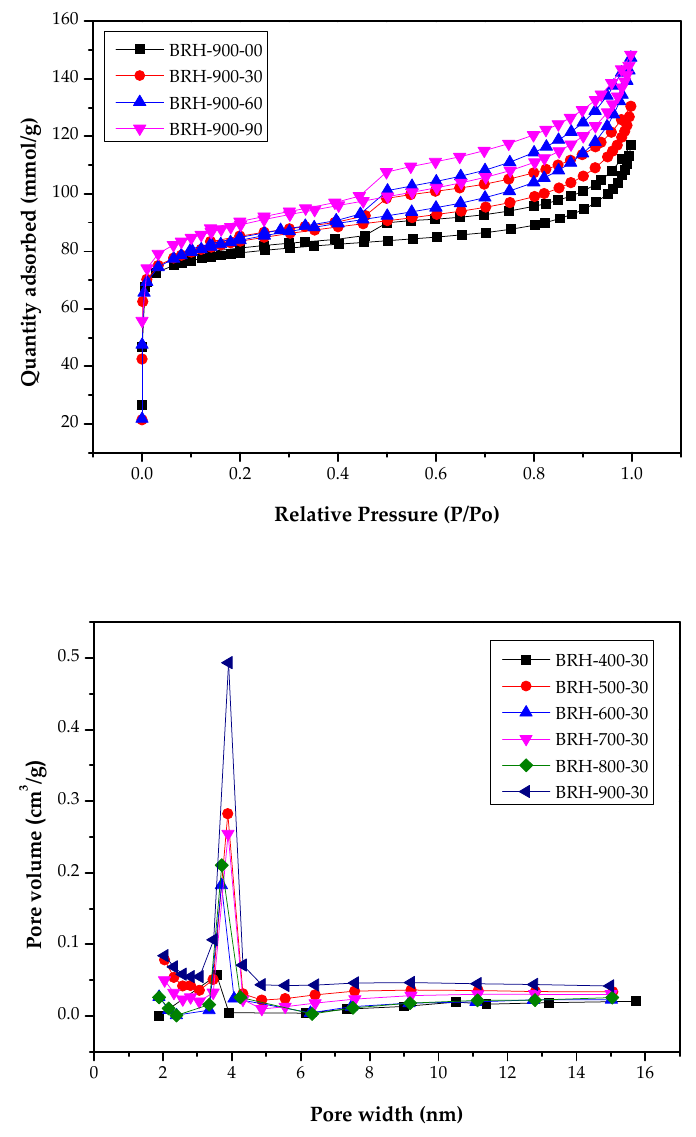
Figure 4. N 2 adsorption–desorption isotherms ( upper ) and pore size distributions ( lower ) of resulting biochar prepared at 900 °C for various holding times.